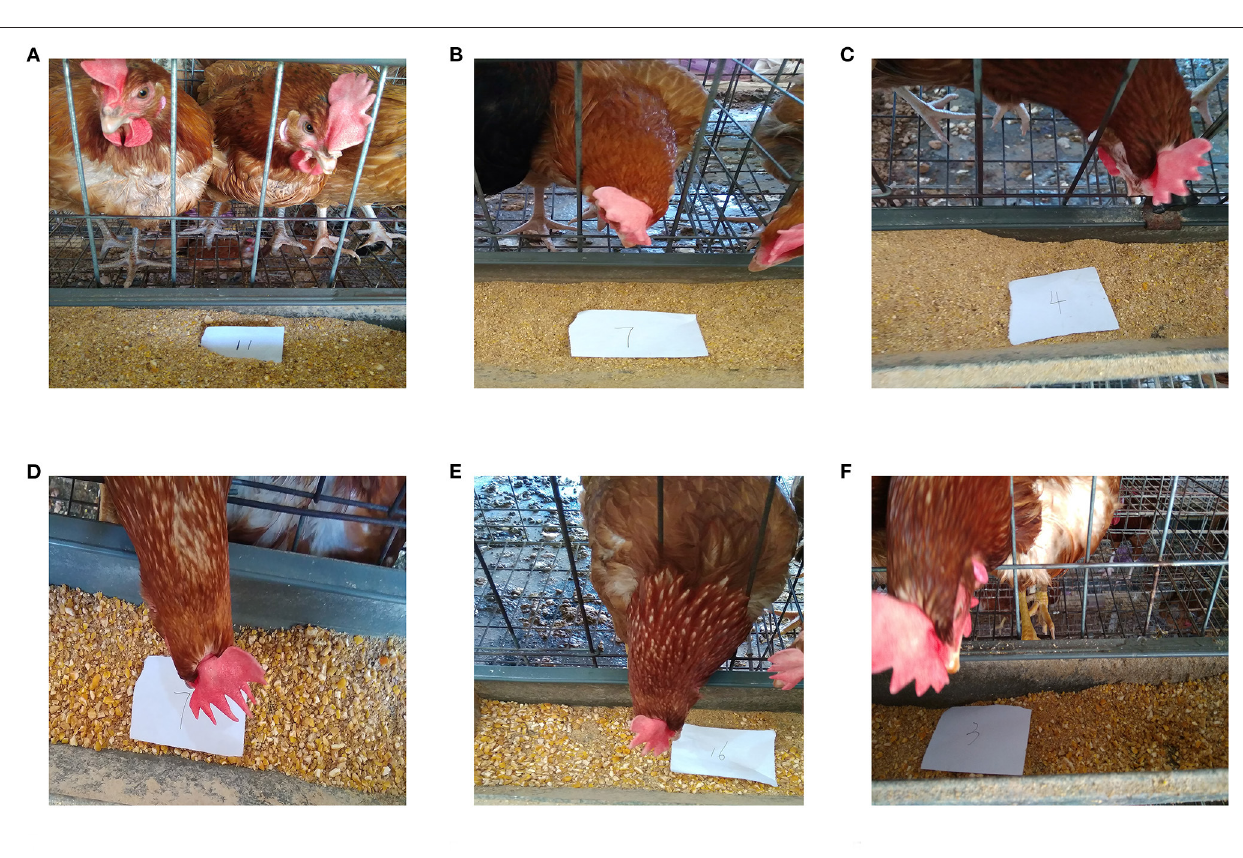
[ Figure 4B (green frame), Figure 4D ] and Alloprevotella in the OH group (4.09%) [ Figure 4C (green frame), Figure 4E ] were significantly greater than those in the OF group (1.72, 2.13%) ( P <